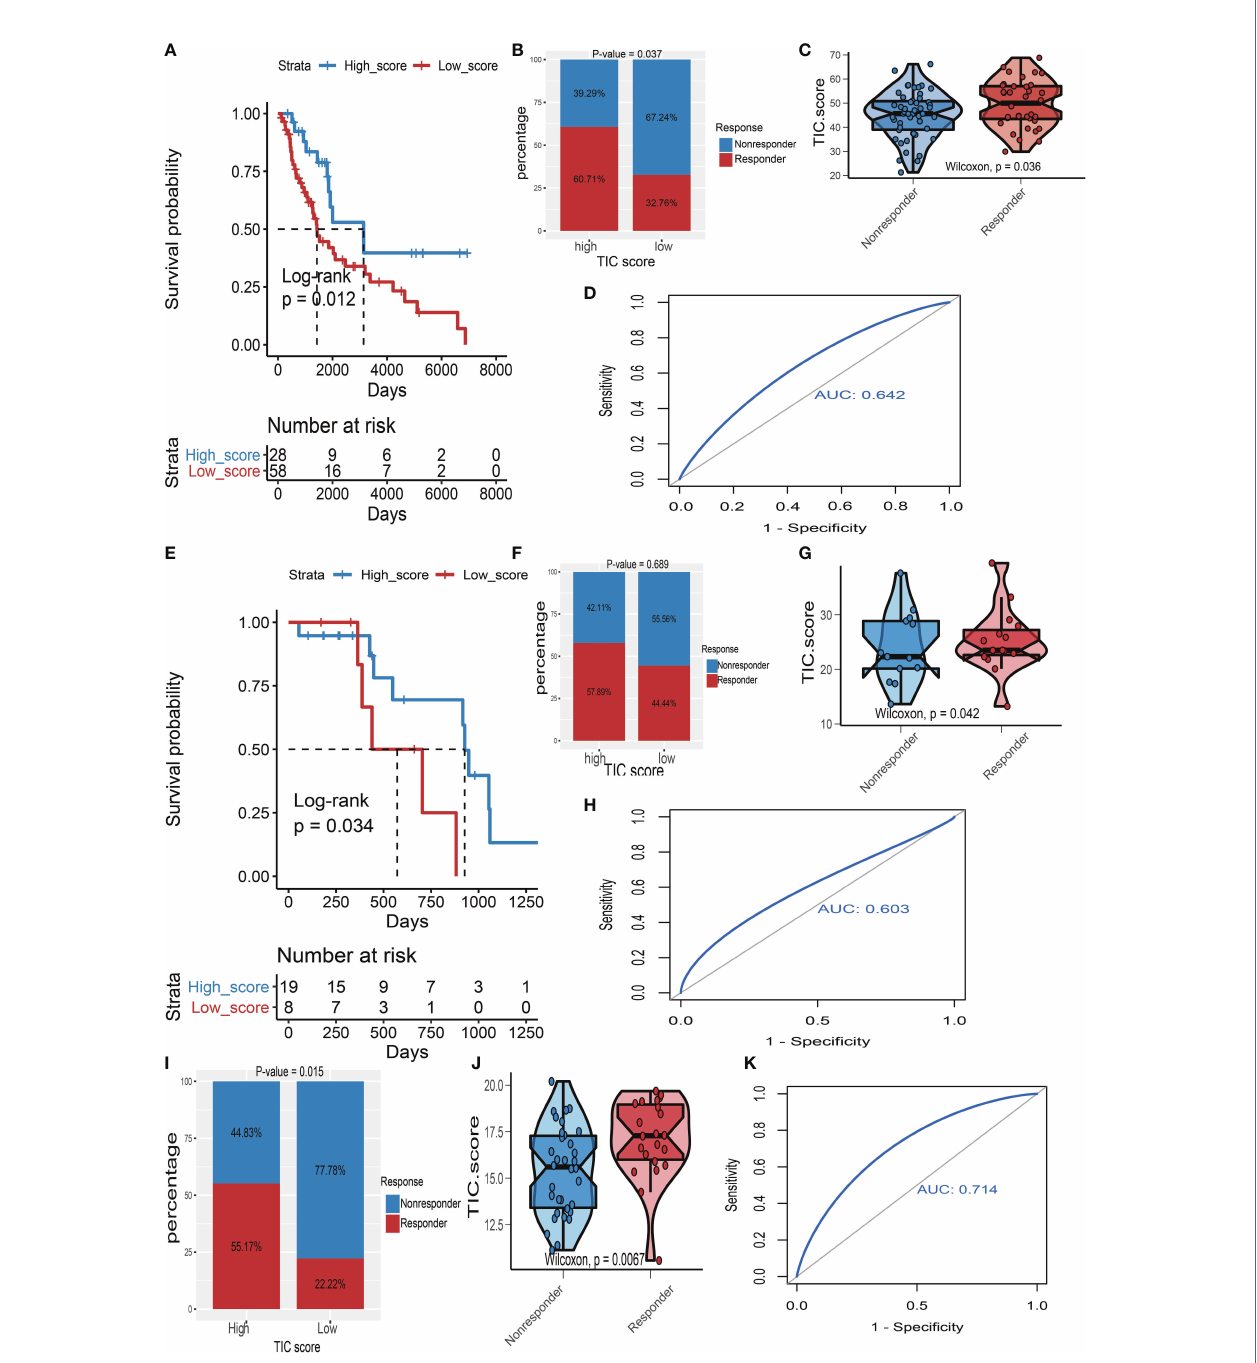
FIGURE 7 | The validation of TIC score for predicting immunotherapy. (A) Kaplan – Meier (KM) curve of high-TIC score and low-TIC score groups in TCGA-SKCM. (B) Immunotherapy response rate of high- and low-TIC score groups in TCGA-SKCM. (C) Distribution of TIC scores between high- and low-TIC score groups in TCGA-SKCM. (D) The receiver operating characteristic (ROC) curve of TIC score in TCGA-SKCM. (E) KM curve of high-TIC score and low-TIC score groups in GSE78220. (F) Immunotherapy response rate of high- and low-TIC score groups in GSE78220. (G) Distribution of TIC scores between high- and low-TIC score groups in GSE78220. (H) ROC curve of TIC score in GSE78220. (I) Immunotherapy response rate of high- and low-TIC score groups in GSE35640. (J) Distribution of TIC scores between high- and low-TIC score groups in GSE35640. (K) ROC curve of TIC score in